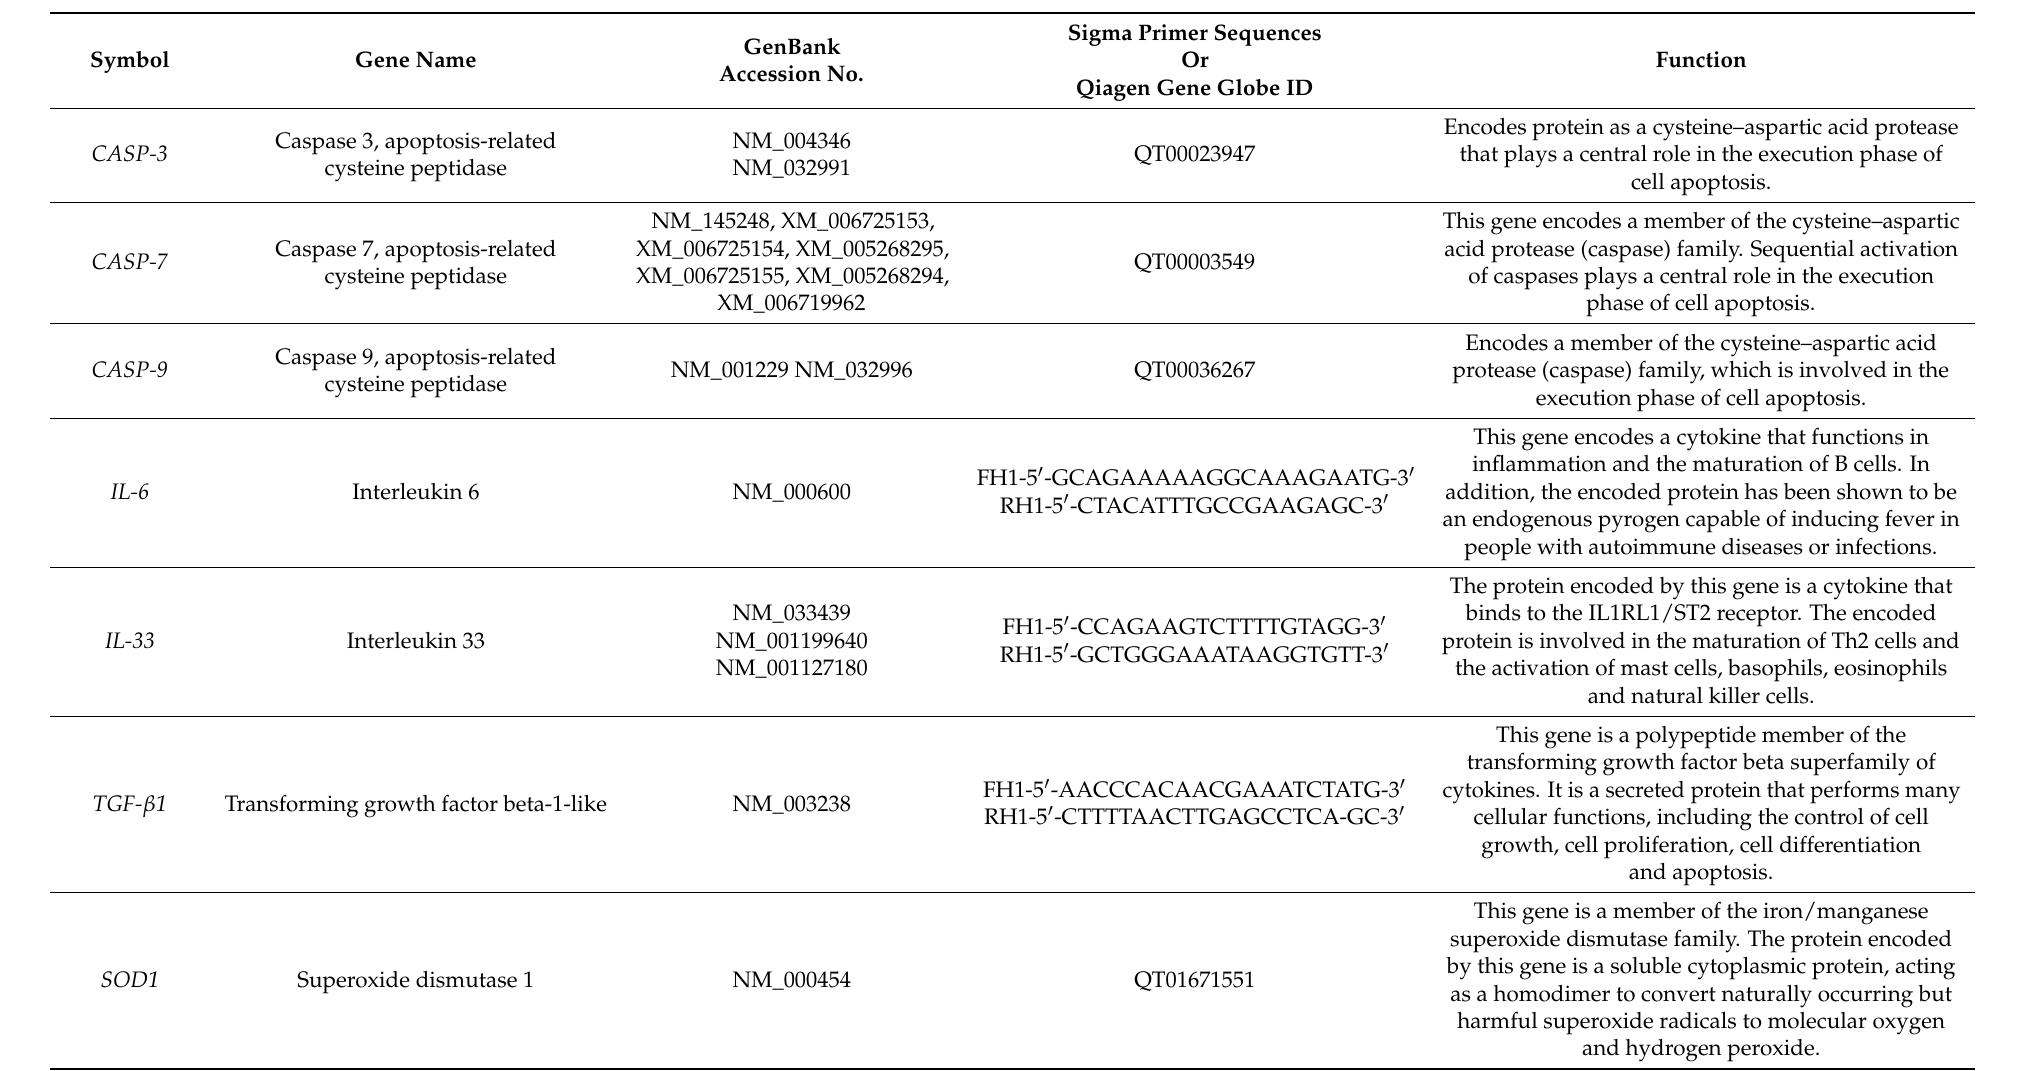
Table 2. Information of the genes associated with inflammatory, apoptotic and antioxidant enzymes pathways in AMD cybrid